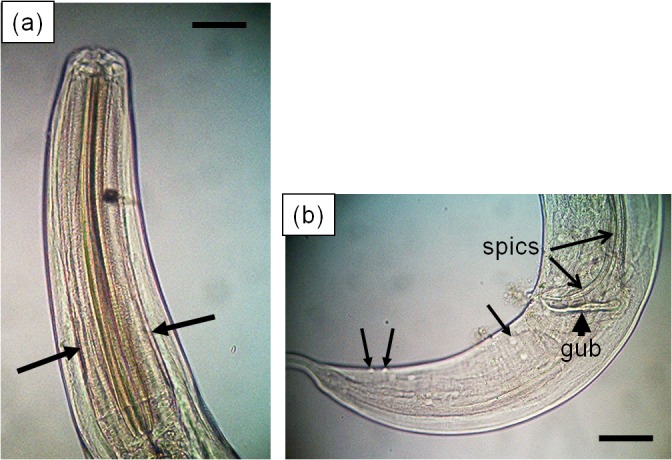
Photomicrographs of a male Atractis sp. nematode detected in a Galápagos giant tortoise faecal sample.Scale bars = 50 μm. (a) Anterior end of body showing wider sclerotised anterior region of the oesophagus [or pharynx] (arrows). (b) Lateral view of posterior end of male showing caudal papillae (closed arrows), gubernaculum (arrowhead) and distal ends of spicules (open arrows).